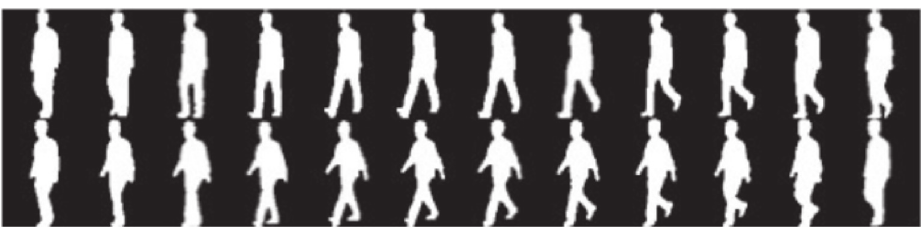
Figure 1: Sample of the CASIA-B gait dataset used for training.